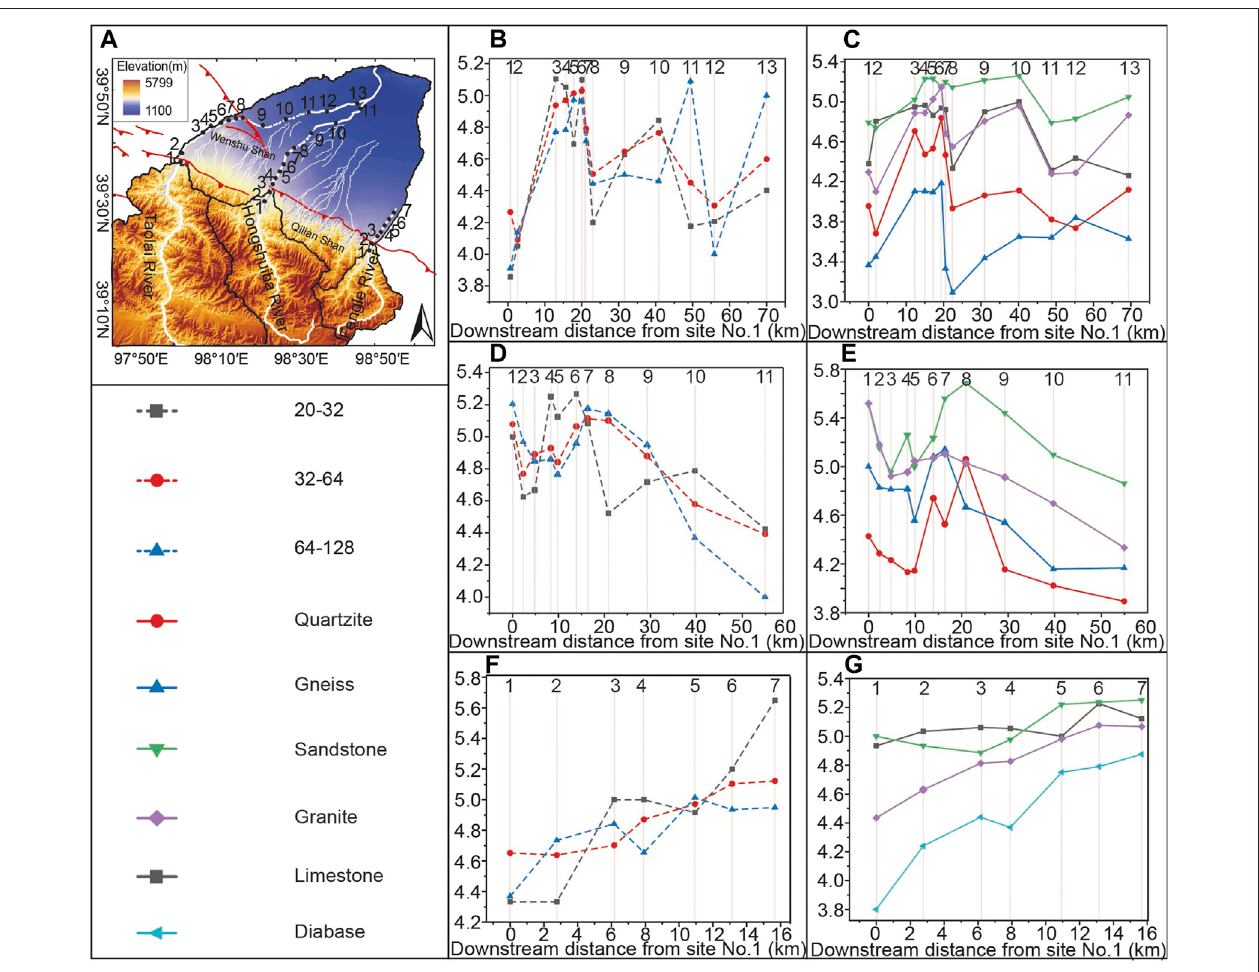
FIGURE 4 | The downstream variation in bedload gravel roundness along the Taolai, Hongshuiba, and Fengle Rivers. (A) The Beida River catchment. It can be divided into the three sub-catchments of the Taolai, Hongshuiba, and Fengle Rivers, in which all sampling sites are marked and numbered in downstream sequence. Dashed lines along the courses of the Taolai and Hongshuiba Rivers indicate their dry riverbeds. (B) – (G) The downstream variation in bedload gravel roundness for differentgravel sizesand lithologies,respectively, alongthe Taolai, Hongshuiba, and Fengle Rivers. Their sampling sites arenumbered incorrespondence with (A) .